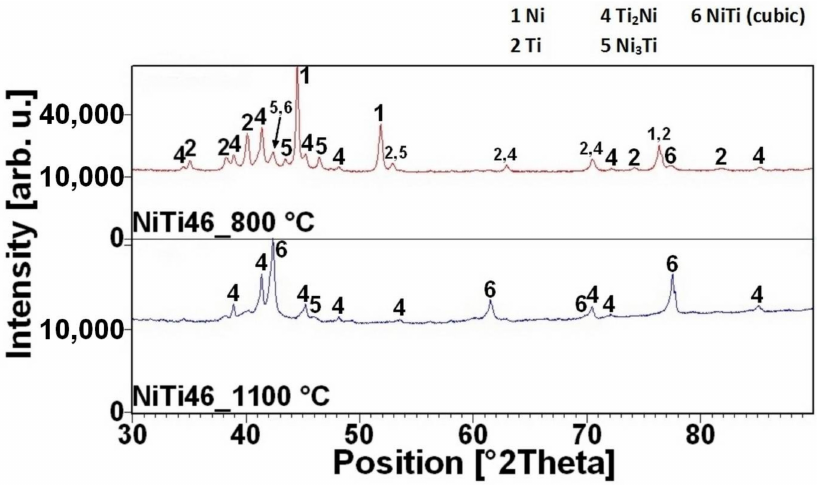
Figure 5. XRD patterns of the NiTi46 sample sintered at 800 and 1100 ◦